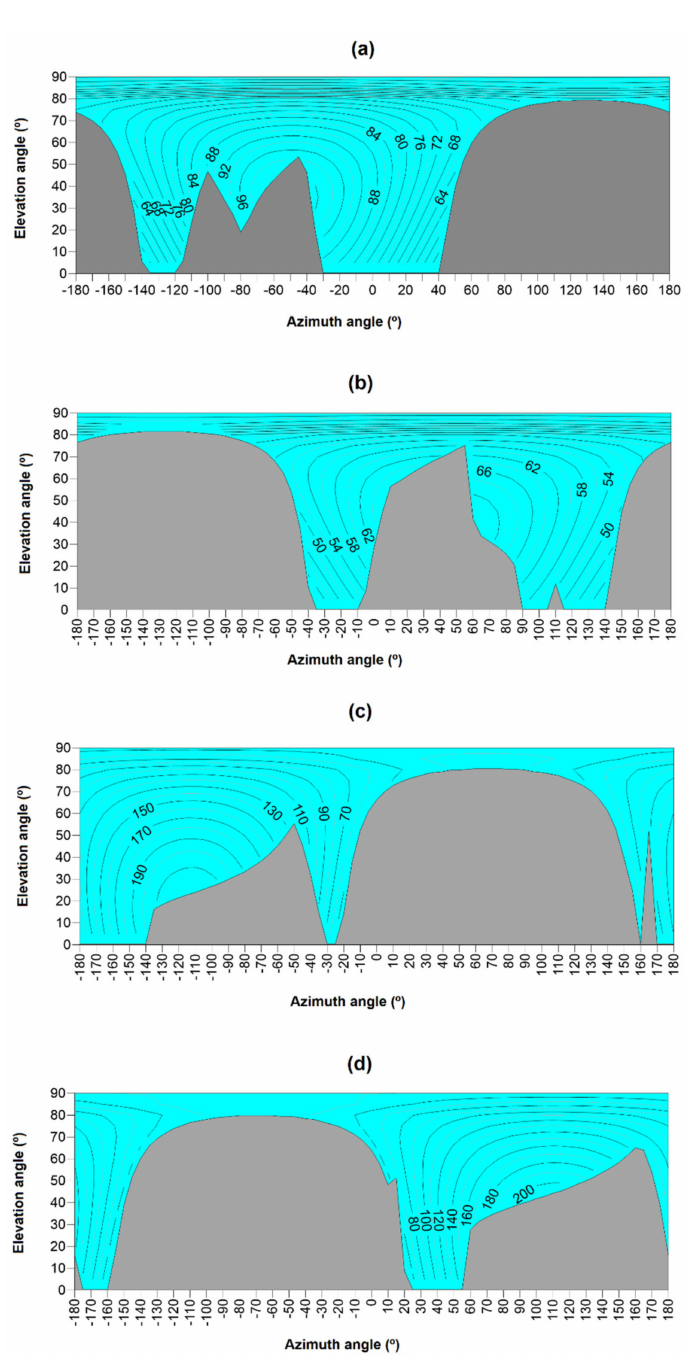
Figure 6. Simulation of the irradiance (W/m 2 ) values registered by the proposed device and the fragmentation of the celestial sphere at different moments of time: ( a ) 21 December at 8:24 a.m. in True Solar Time, ( b ) 21 December at 15:24 p.m. in True Solar Time, ( c ) 21 June at 7:30 a.m. in True Solar Time, and ( d ) 21 June at 15:48 p.m. in True Solar Time.